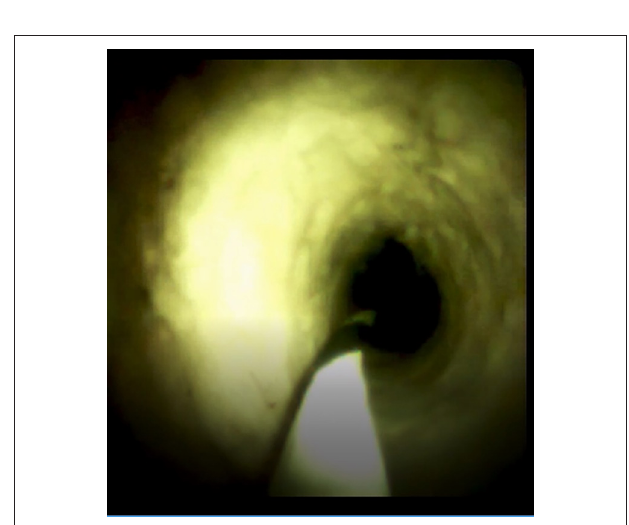
FIGURE 7 | SpyGlass DS system image showing the change after radiofrequency